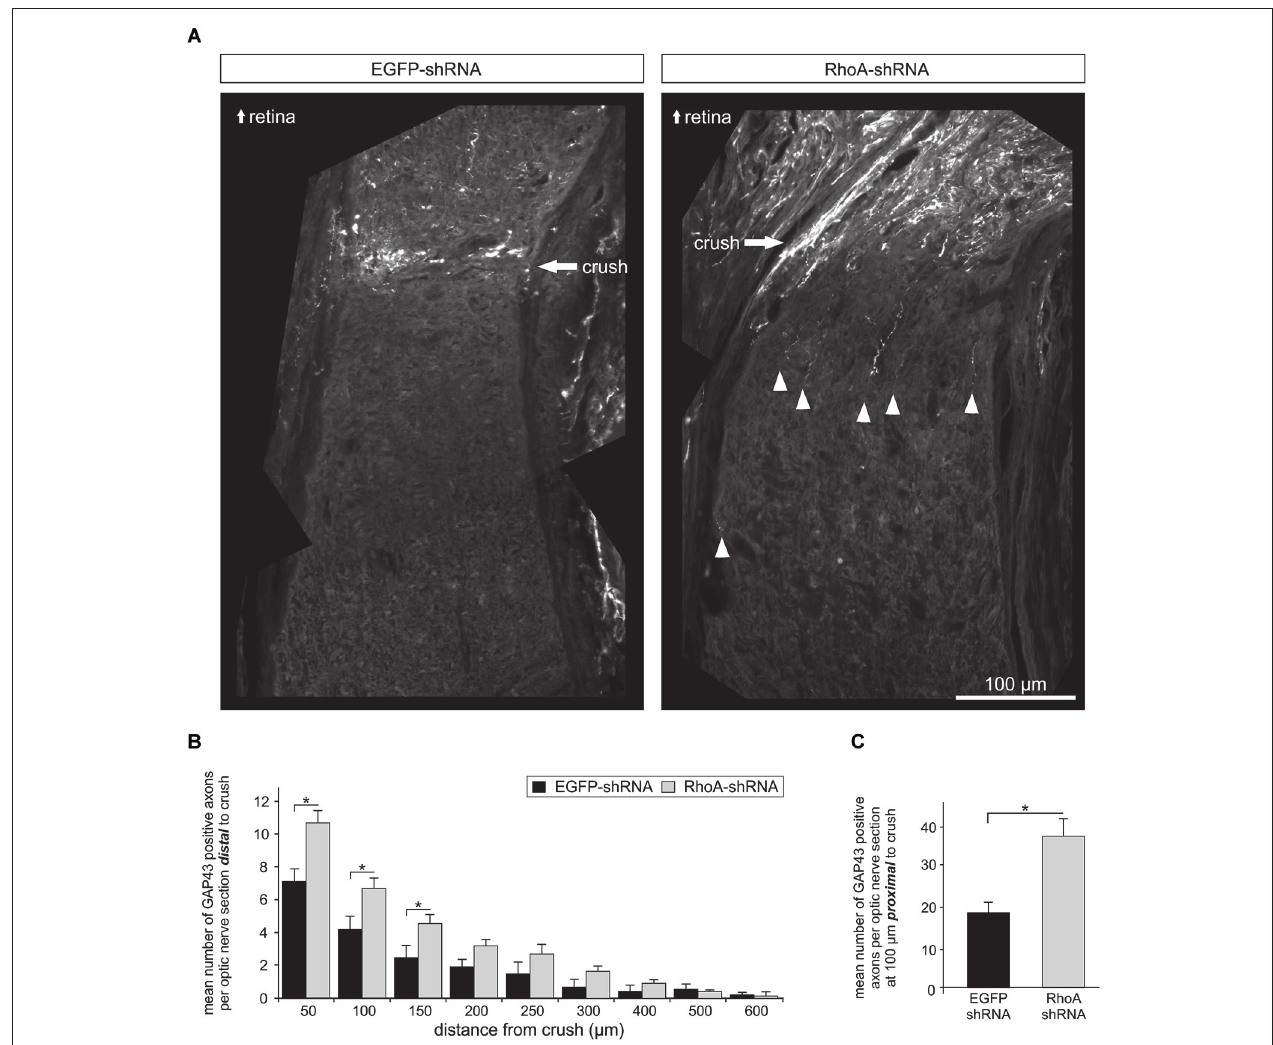
( n = 10 optic nerves per group; bars represent means ± SEM; * p < 0.05; ** p < 0.005 according to Student’s t -test). (C) Quantification of the number of GAP43-positive axons at 100 µ m proximal to the crush site shows a significant increase only for the optic nerves transduced with AAV.RhoA-shRNA ( n = 10 optic nerves per group; bars represent means ± SEM; * p < 0.05, according to Wilcoxon (Mann-White) test for unpaired